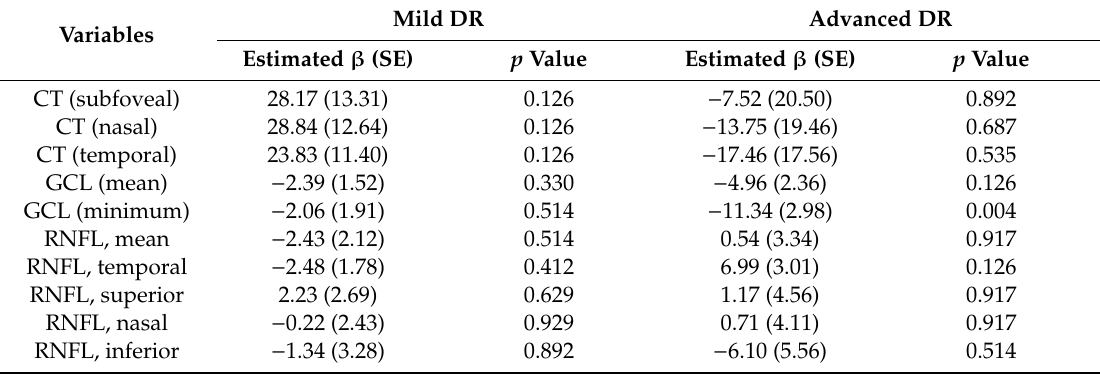
Table 3. Multivariate analysis of the association between the ophthalmological variables and the grade of diabetic retinopathy in patients with type 1